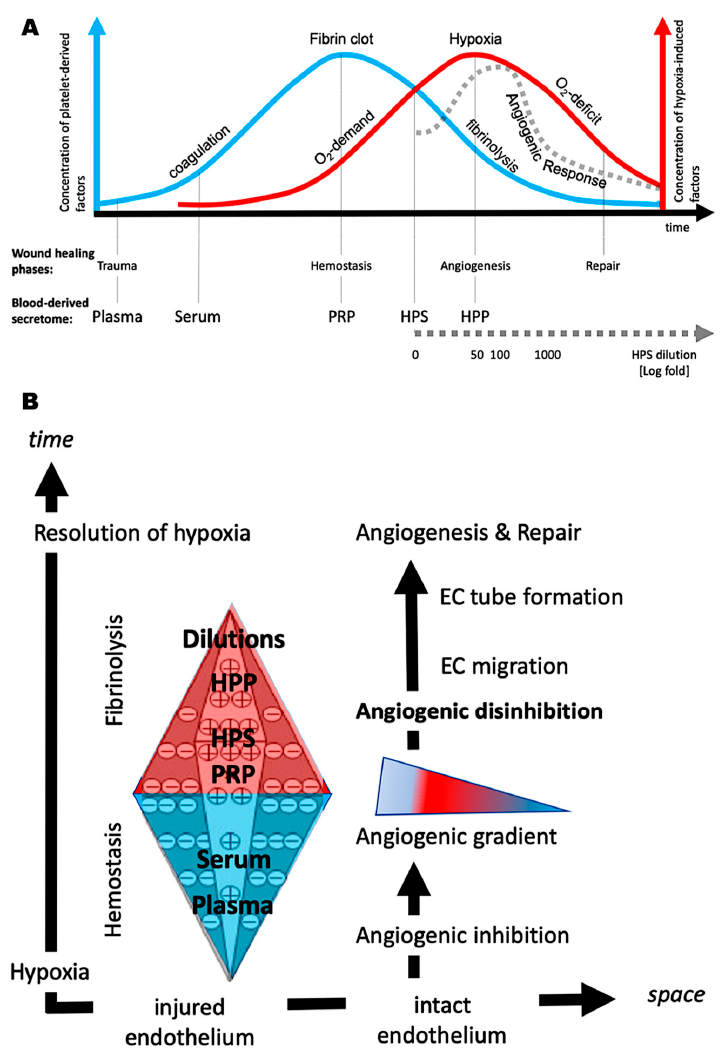
Figure 8. Biological basis underlying the utilization of different blood-derived secretomes. ( A ) Plot showing the representative correlation of different types of blood-derived secretomes (plasma, serum, PRP, HPS, HPP) with the progressive phases of wound repair. The coagulation-induced signaling phase (platelet-derived growth factors; blue curve) that supports haemostasis, correlates with PRP since it depends on the maximum concentration of platelets, while the hypoxia-induced signaling phase (PBC-derived growth factors; red curve) that drives angiogenesis, correlates initially with HPS, and eventually with HPP and HPS dilutions. The shape of the dotted gray curve represents the net angiogenic response, and is theoretically defined by subtracting anti-angiogenic platelet-derived signaling (blue curve) from pro-angiogenic hypoxia-induced signaling (red curve). ( B ) Proposed mechanism for the biochemical control of wound angiogenesis, and correlation of the various blood-derived secretomes (plasma, serum, PRP, HPS, HPP) with the different wound healing phases. Following completion of the haemostatic phase, the fibrin matrix undergoes controlled degradation through fibrinolysis, leading to depletion in the local pool of anti-angiogenic factors (e.g., PF-4) which are bound to fibrin (indicated by ‘’-‘’ sign), while up-regulation of pro-angiogenic factors (e.g., VEGF) though hypoxia (indicated by ‘’+’’ sign) leads to the formation of chemoattractive gradients that direct endothelial cell (EC) migration towards the injured site. Angiogenic disinhibition enables vascularization of the matrix through fibrinolysis-mediated EC invasion, which facilitates resolution of hypoxia and tissue repair. From a cell-biological perspective, hypoxic preconditioning of peripheral blood may o ff er an additional advantage, beyond the direct hypoxia-induced upregulation and optimization of